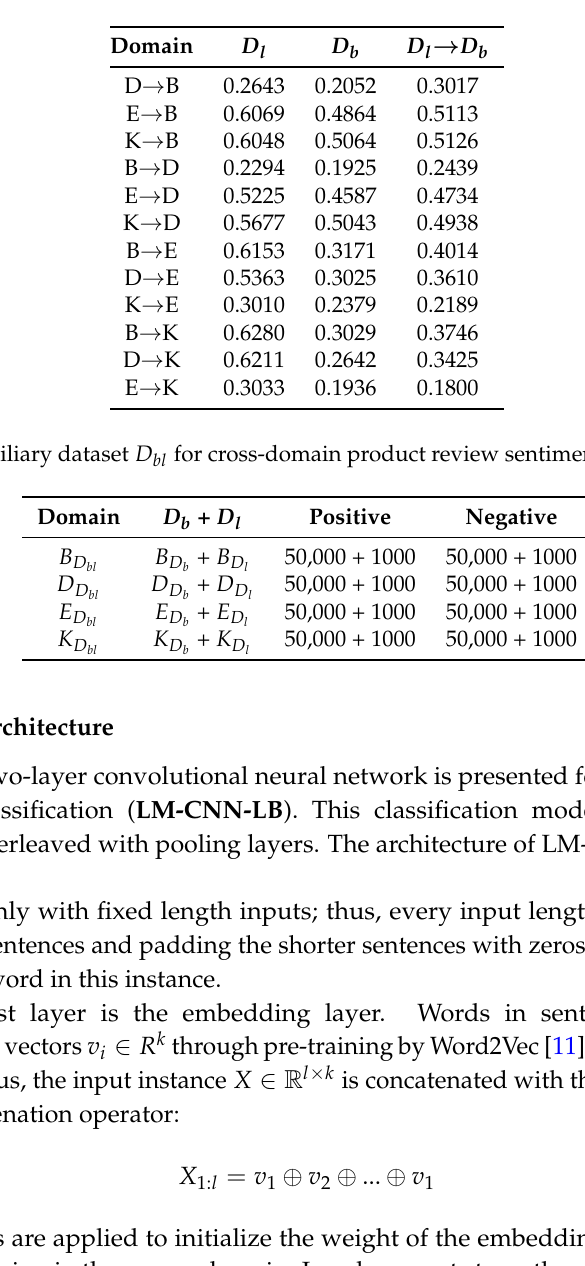
Table 2. KL divergence of different domains.